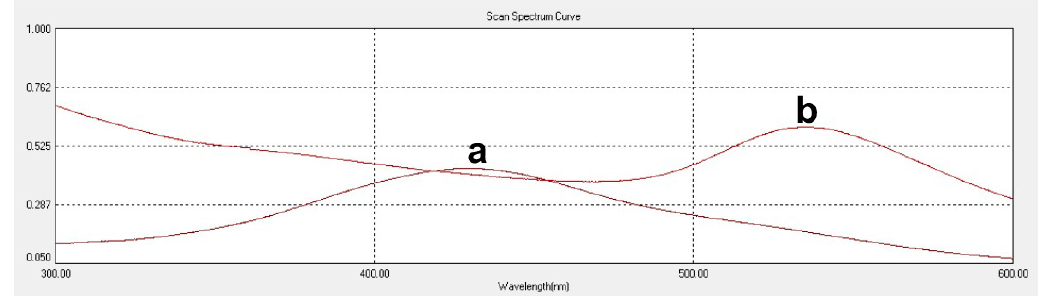
Figure 1. UV-VIS spectra of curcumin (a) and curcumin-gold nanoparticle (b).